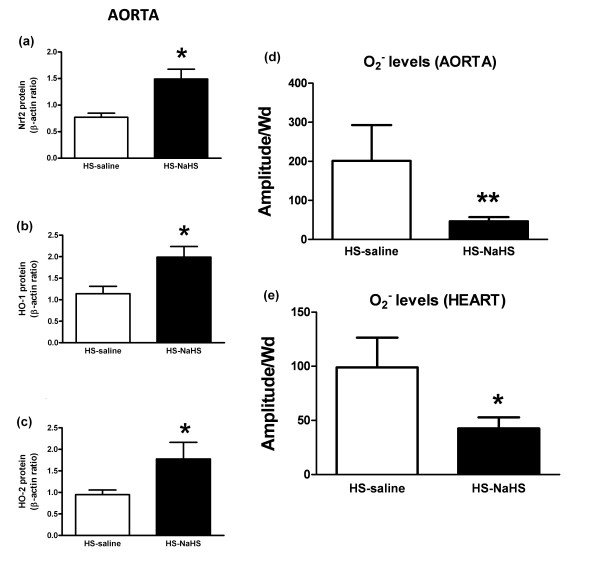
Effects of NaHS on antioxidant pathway. (a, b, c) Western blots revealing in aorta Nrf2 (a), HO-1 (b) and HO-2 (c) in the whole lysate of aortas (n = 6). (d, e) Quantification of the amplitude of O2--Fe(DETC)2 signal in unit/weight (mg of the dried sample Amplitude/Wd, n = 10) in the aorta (d) and heart (e) of the two groups of rats. Data are expressed as mean ± SD. *P < 0.05 and **P < 0.01, significantly different between HS-saline and HS-NaHS groups.